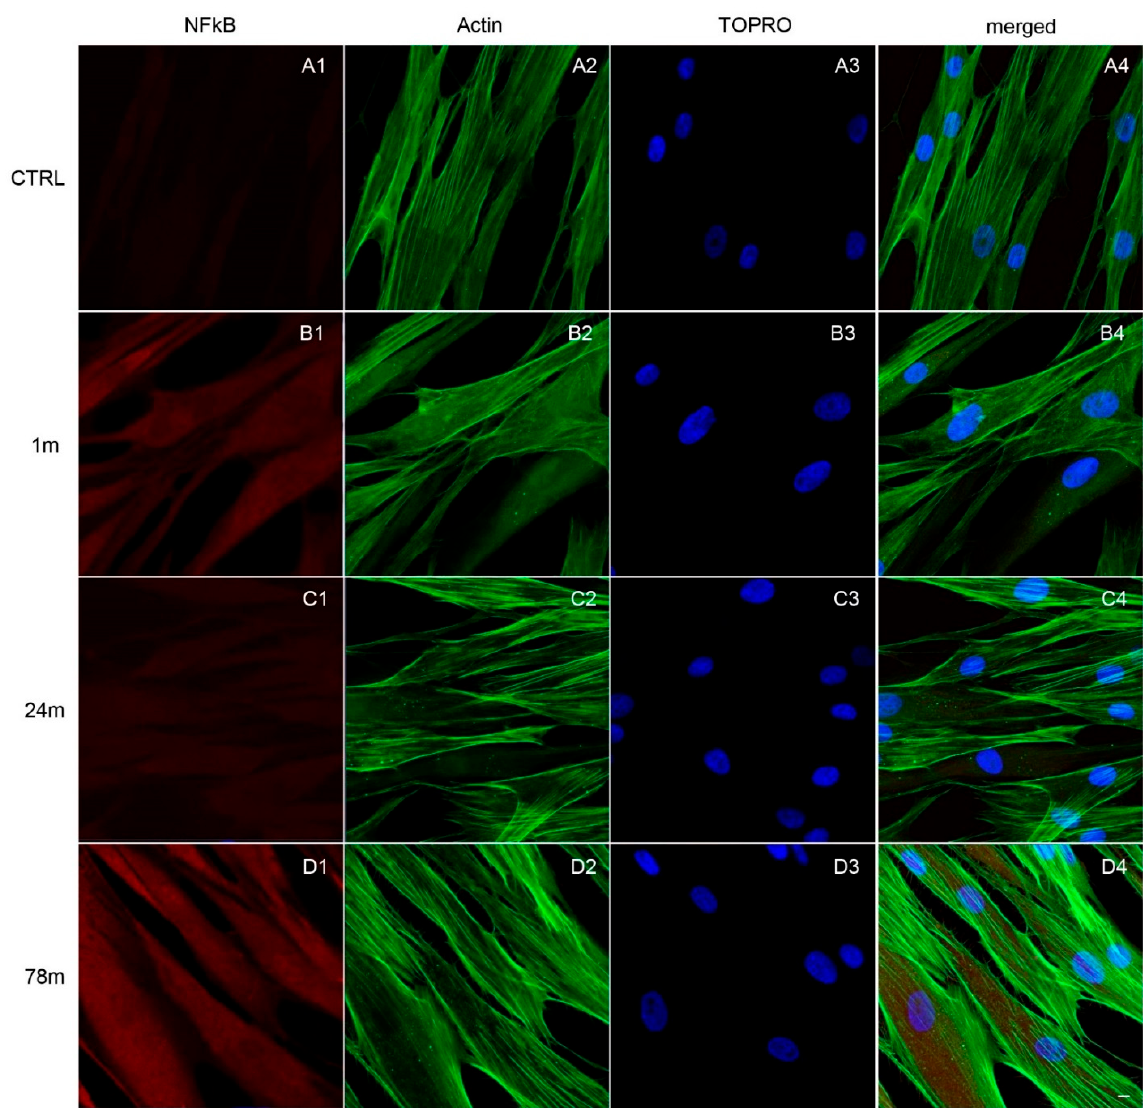
Figure 3. Graph bars indicating the optical density obtained by means of MTS assay at 24, 48 and 72 h of culture. * p < 0.05; ** p < 0.01; *** p < 0.001.